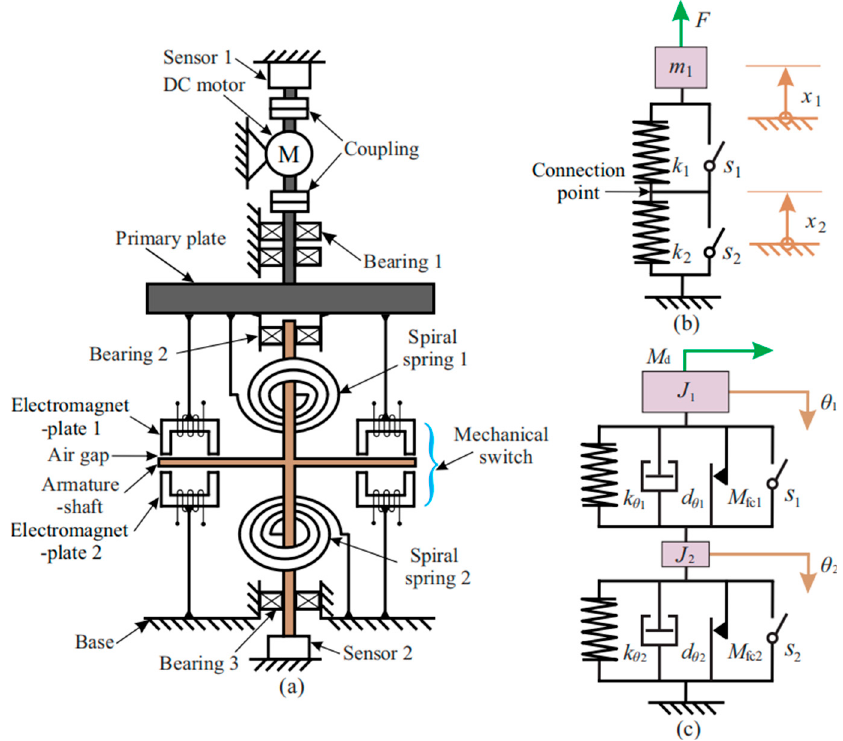
Figure 2. ( a ) Principle of the experimental 4S; ( b ) translational model of the 4S; ( c ) rotational model of the experimental 4S.